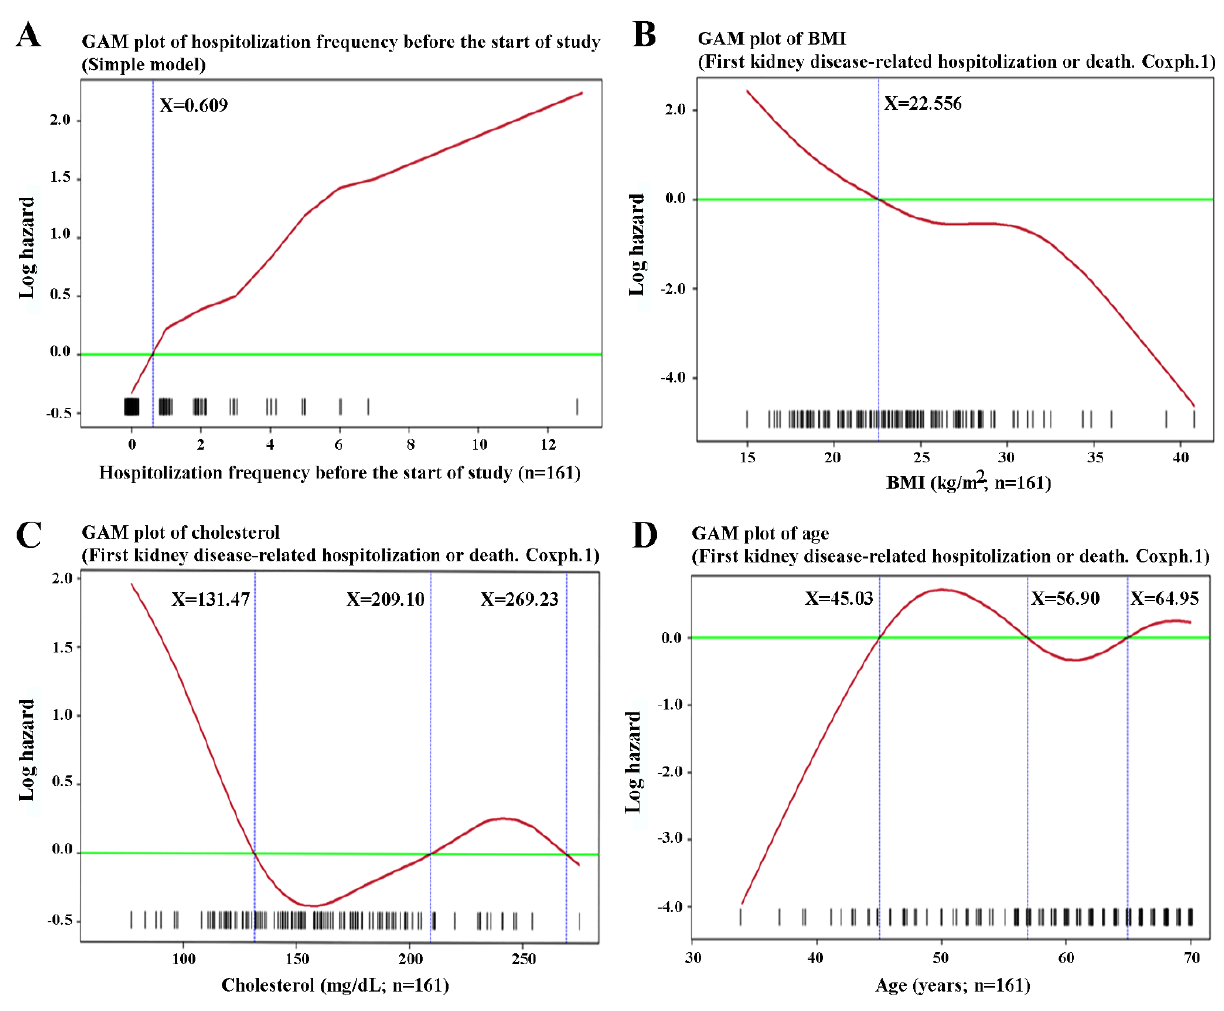
Figure 4. Generalized additive model (GAM) plots of the first kidney disease − related hospitalization or death versus ( A ) hospitalization frequency within 1 year before the start of the study (0.3345